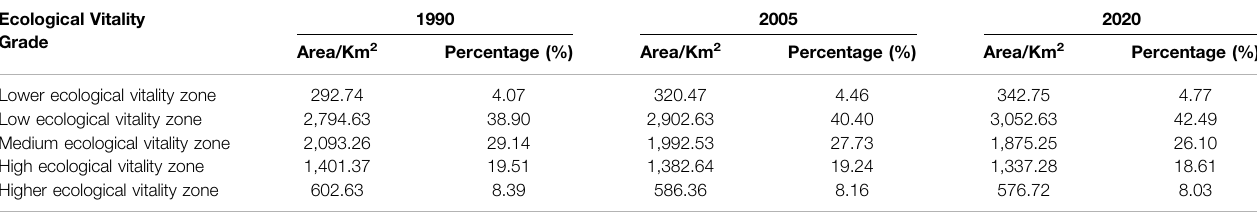
TABLE 9 | Area and percentage of ecosystem vitality at each